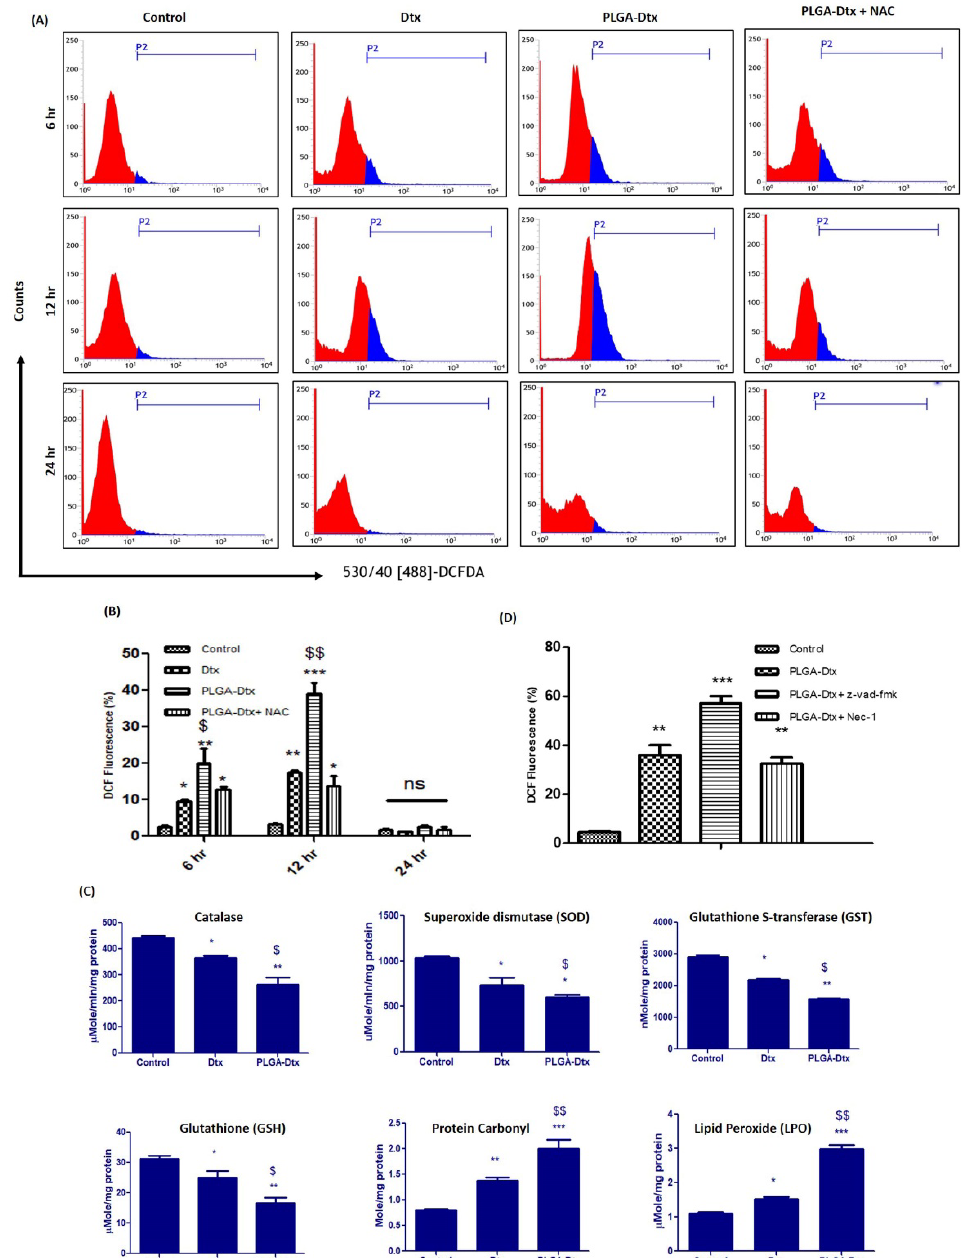
Figure 4. ROS production resulting from exposure to PLGA-Dtx in A549 cells. ( A ) Cells were pretreated with antioxidant NAC for 30 min and subsequently treated with IC50 value of PLGA-Dtx for different periods (6, 12, and 24 h), and then intracellular ROS was measured by DCFH2-DA fluorescence; ( B ) representative bar diagram to show the change in DCF fluorescence; ( C ) effect of Dtx and PLGA-Dtx exposure on antioxidant enzymes and oxidative stress markers in A549 cells; ( D ) representative bar diagram for showing the effect of Z-VAD-fmk and Nec-1 on ROS production. Data were the mean ± SEM from at least three independent experiments. (* p < 0.05, ** p < 0.01, and *** p < 0.001 compared with the control group.), ($ p < 0.05 and $$ p < 0.01 compared with the free Dtx). NAC is a widely used antioxidant and pretreatment with NAC abrogated the in- duced ROS. Intracellular antioxidant enzyme systems tightly regulate ROS production, and the amount of these antioxidant enzymes is either raised or lowered to shield cells